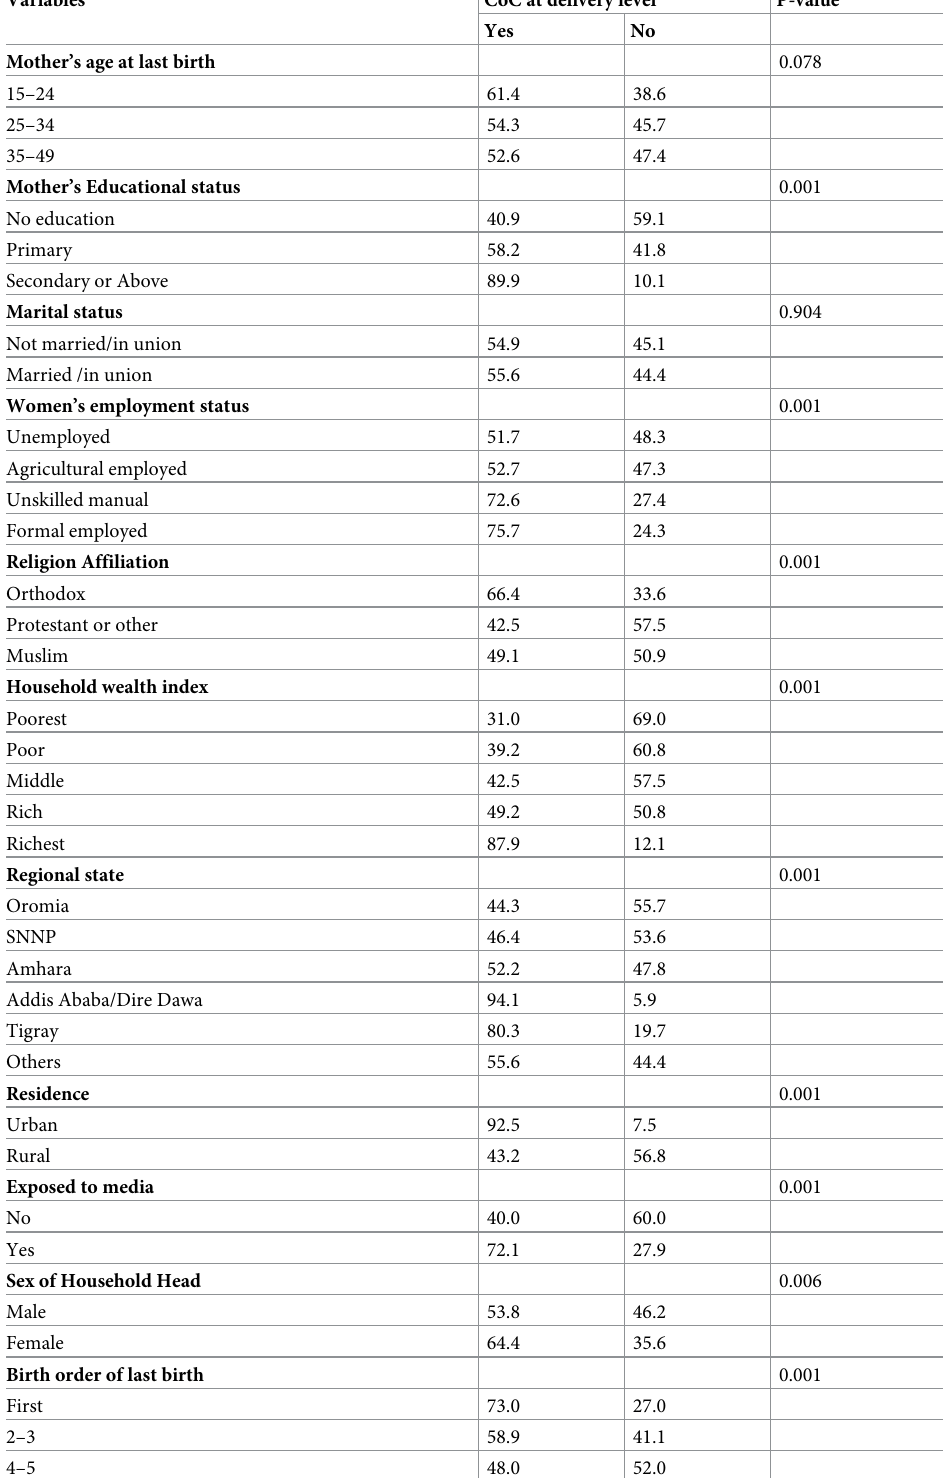
Table 2. Distribution of CoC at the delivery level by selected explanatory variables (N =